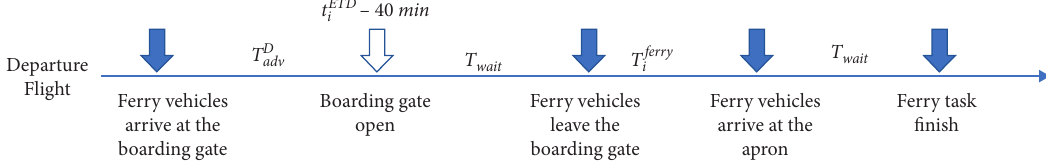
Figure 7: Ferry vehicle service process of departure